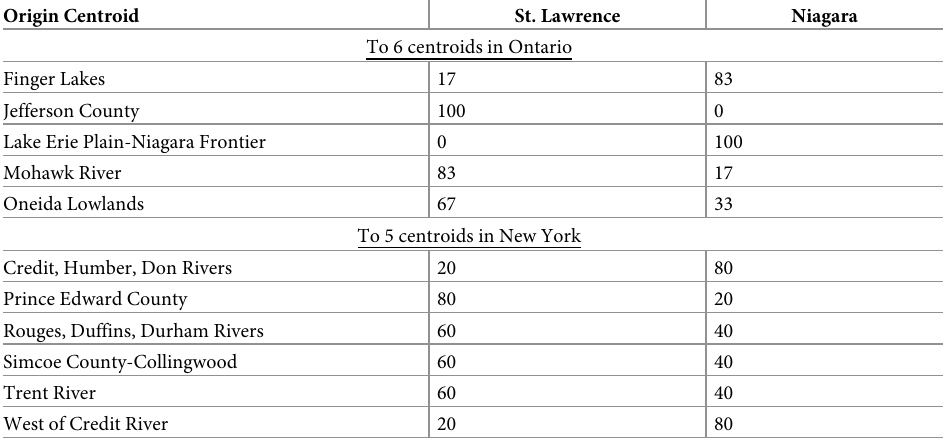
Table 1. Percentage of LCPs crossing the St. Lawrence or Niagara River from or to New York or southern